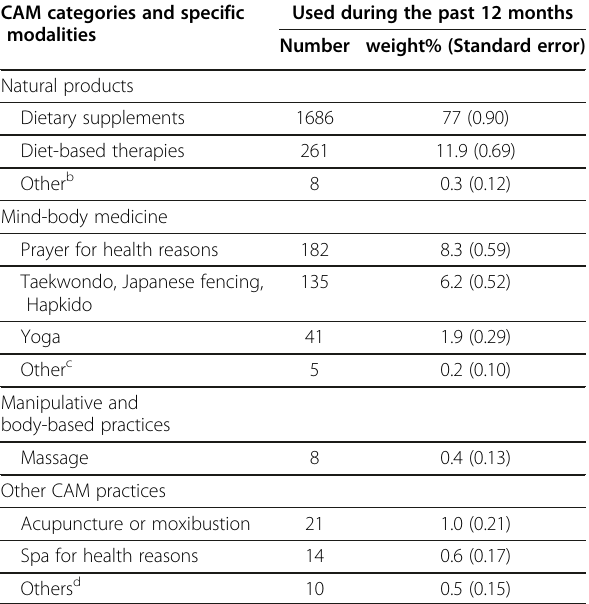
Table 2 Frequencies of child complementary